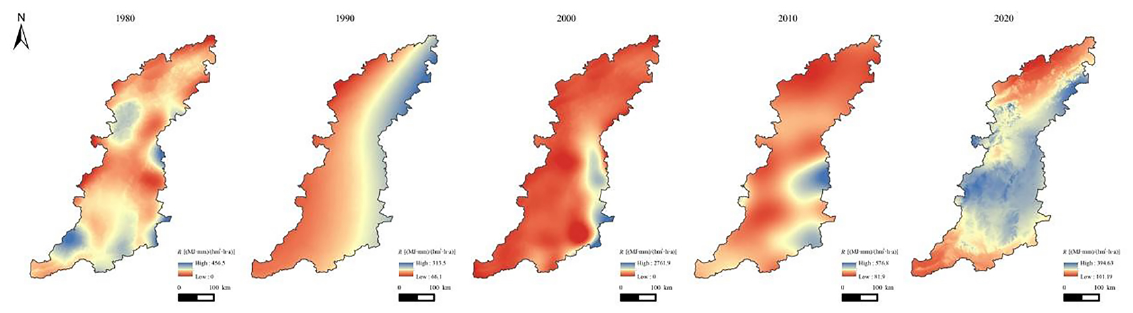
Figure 3. Spatial distribution of rainfall erosion factor ( R ) in the Taihang Mountain area from 1980 to